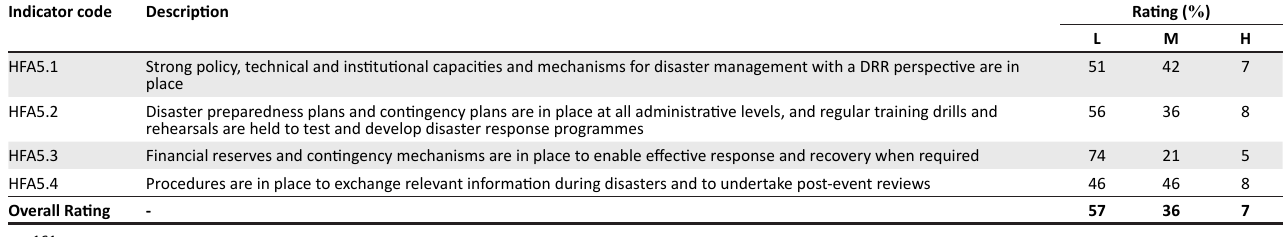
TABLE 6: Perceptions of respondents with regard to achieving Hyogo Framework for Action 5: Strengthen disaster preparedness for effective response at all levels. Indicator